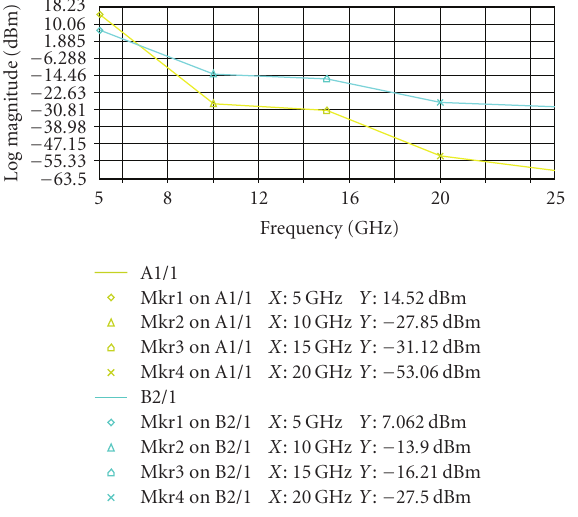
Figure 6: Measured frequency-domain NLTL spectrum for a 13.9dBm input at 5GHz.